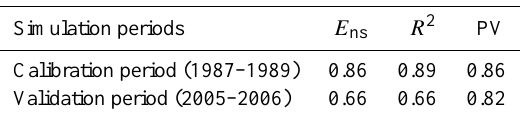
Table 2. Evaluation for simulation results of monthly outflow dur- ing calibration and validation periods in the Zhalong wetland, Northeast